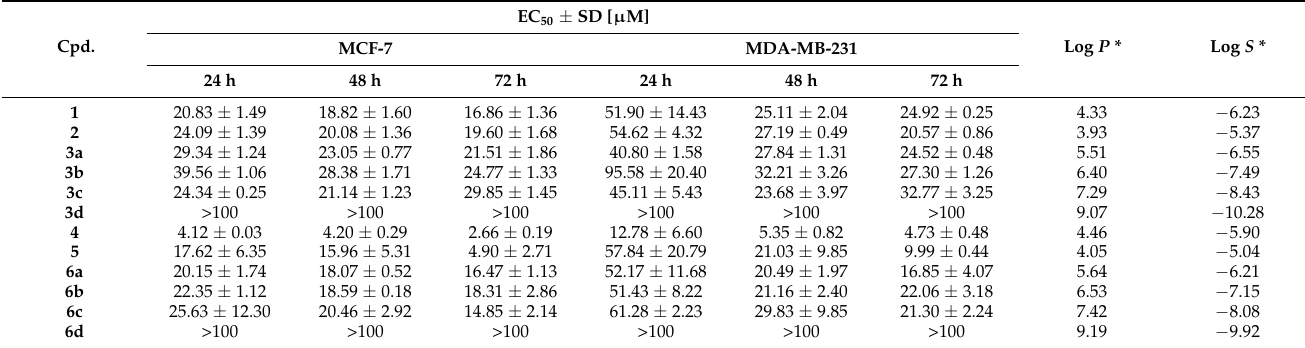
Table 2. Viability of MCF-7 and MDA-MB-231 human breast carcinoma cells after the treatment with the tested compounds. The EC 50 values were calculated using MTT-based assay and an equation Y = 100/(1 + 10ˆ((LogIC 50 − X) * HillSlope)).